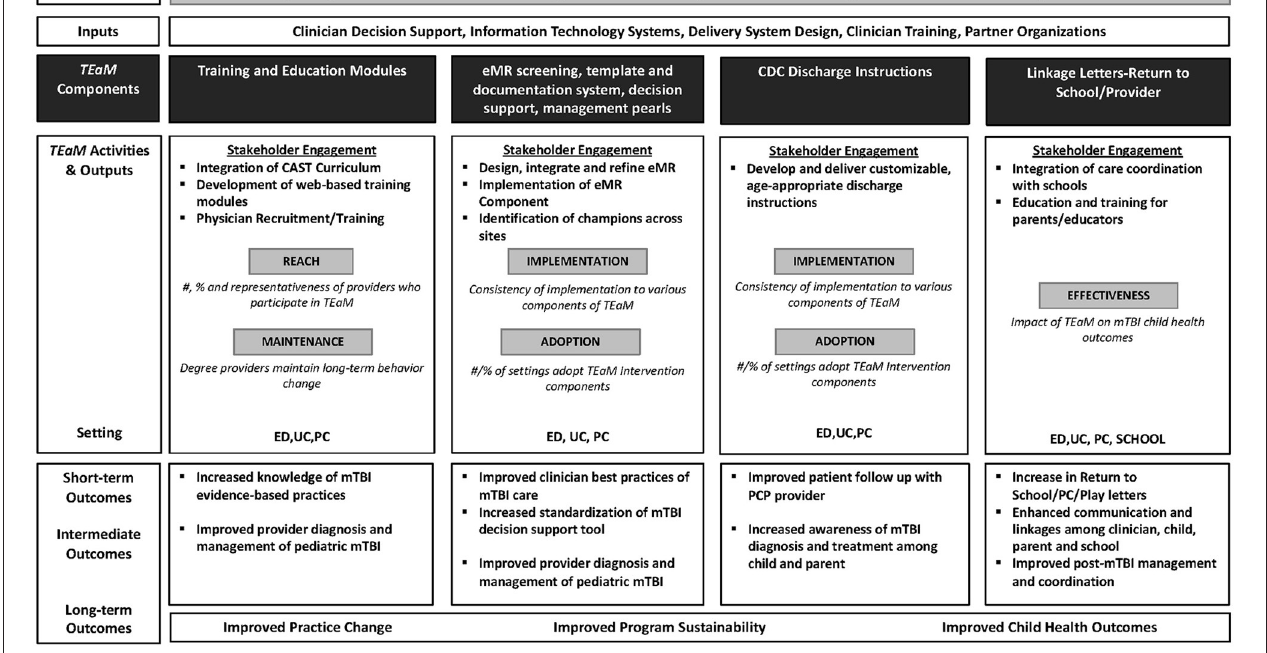
FIGURE 2 | TEaM Logic Model inspired by and adapted from “Logic model for the BETTER 2 program” by Donna Patricia Manca et al. licensed under CC BY 4.0.